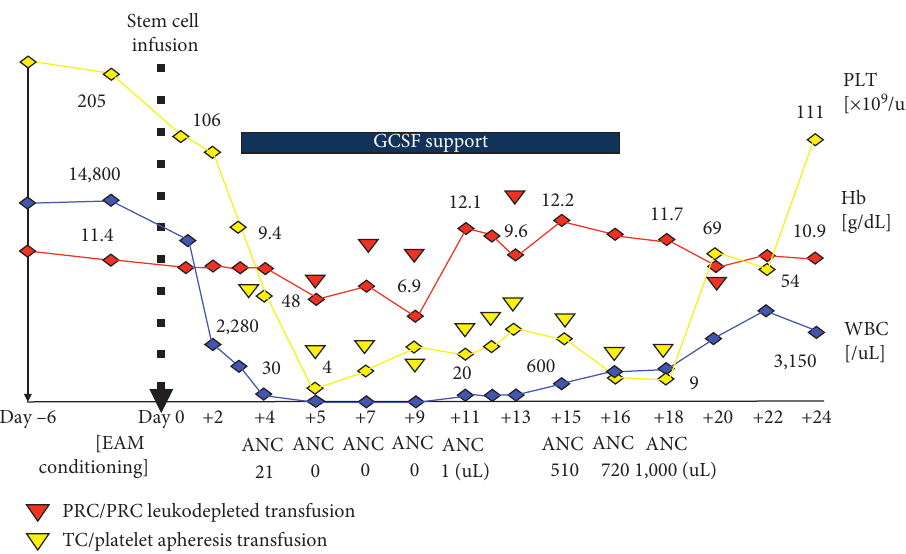
Figure 4: Day-to-day transplant evaluation from conditioning chemotherapy until engraftment. ANC, absolute neutrophil count; Hb, hemoglobin concentration; Plt, platelet count; PRC, packed red cells; and WBC, white blood cell